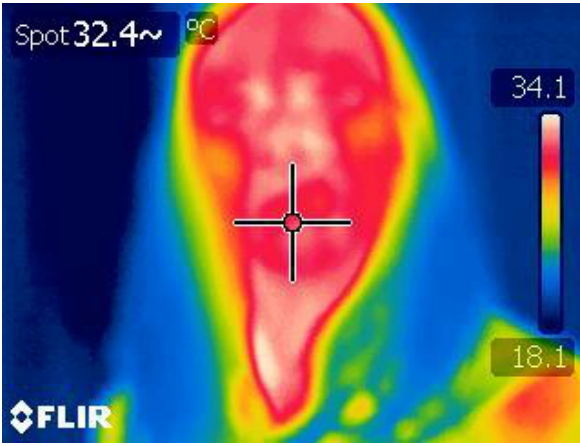
Figure 18. Foam seen at the eave